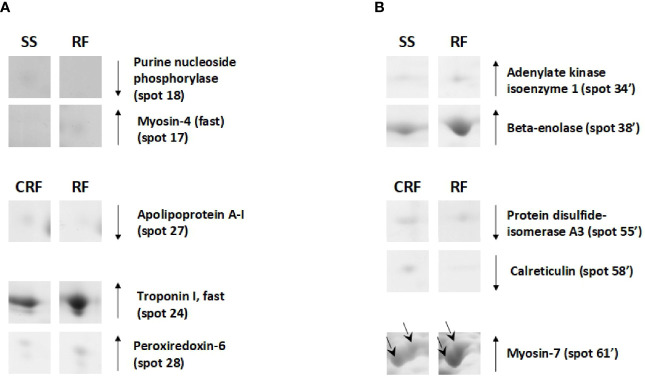
RF–dependent differentially represented proteins in tibialis anterior (A) and soleus (B). Representative subsections of 2D-E images of tibialis anterior and soleus. SS, semi-starved rats; CRF, control of refed rats; RF, refed rats. A selection of spots is shown. Identified protein spots belong to those showing a relative intensity that differed significantly between experimental groups by at least 2-fold with a p<0.05 (Student’s t-test). Down arrows mean a reduced representation; up arrows mean an increased representation. Effects of RF are reported vs. SS and CRF. Spot numbering refers to 
Figure 5
 and
Supplementary Data 2
.